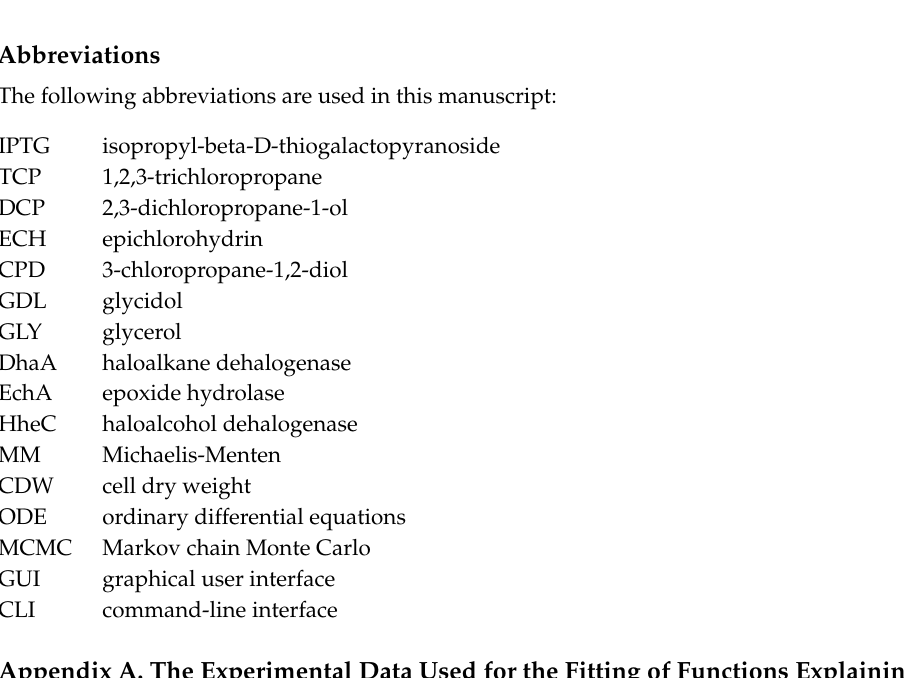
Figure S13: The results of robustness monitoring for Property 7 with extended range of the death rate coefficient; Table S1: The quantitative results for fitting of the functions explaining the enzymes concentration reflecting IPTG; and Table S2: The results of fitting several growth functions to the same set of experimental